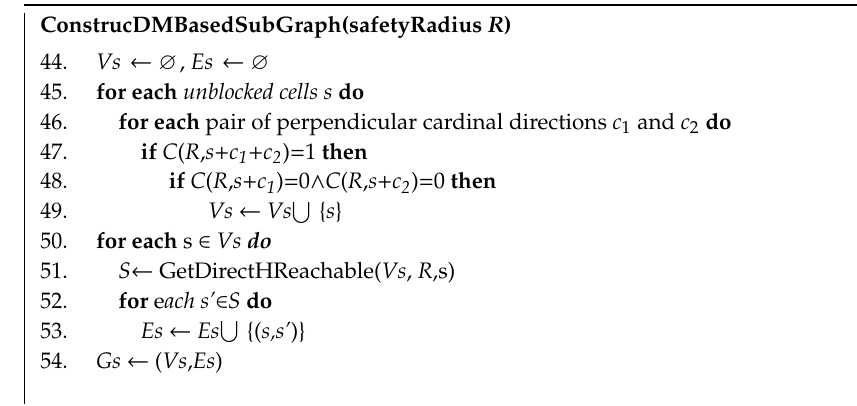
Table 3. The pseudocode for constructing DM-based subgoal